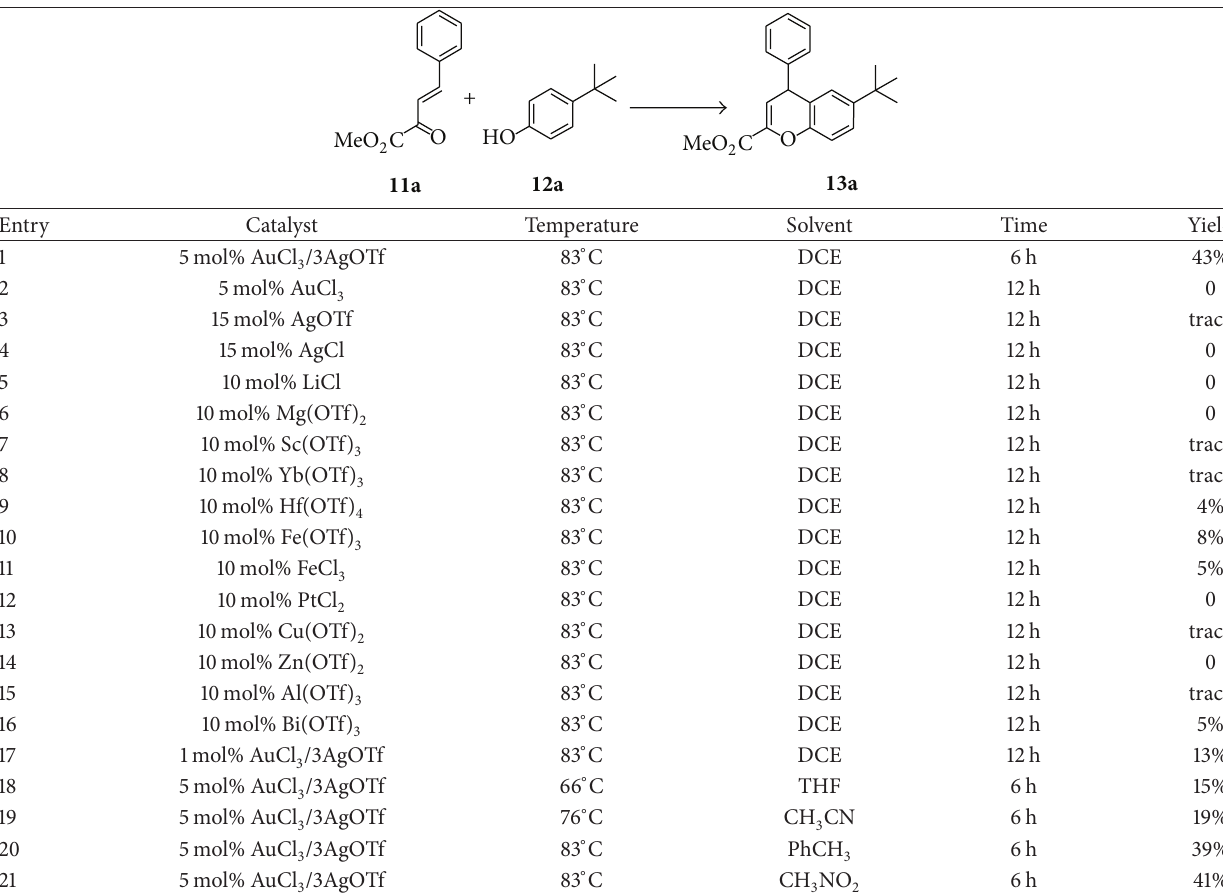
Table 1: Survey of conditions for the condensation of 11a with 12a a